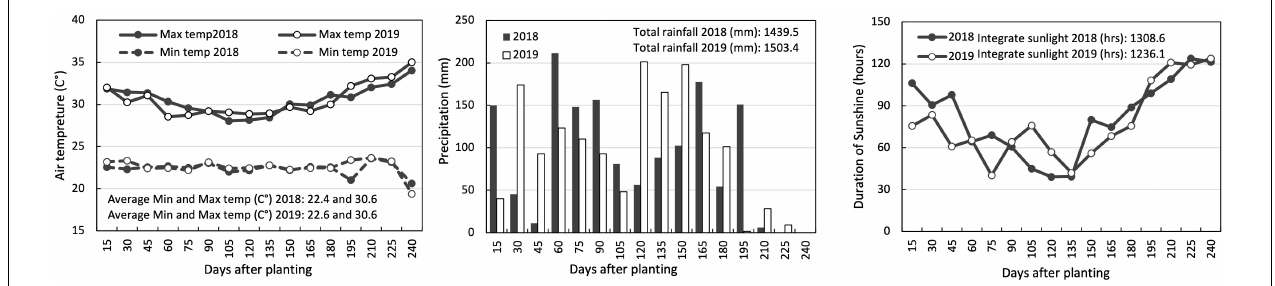
FIGURE 1 | Air temperature, precipitation, and duration of sunshine during the growth periods at IITA Ibadan, Nigeria. The air temperature (left box) includes solid lines and dashed lines representing maximum and minimum air temperature averages, respectively, for every 15 days after planting. For precipitation (center box) and sunshine duration (right box), data are cumulative values for every 15 days after